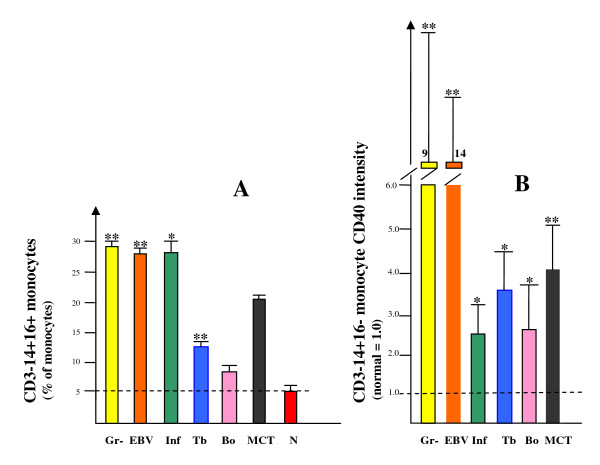
Monocytes: (A), fraction among all monocytes of the CD16+ subtype; and (B), activation status as determined by CD40 expression. The dashed lines indicate the level of the normal controls. *p < 0.02 or 0.05, ** p < 0.01.